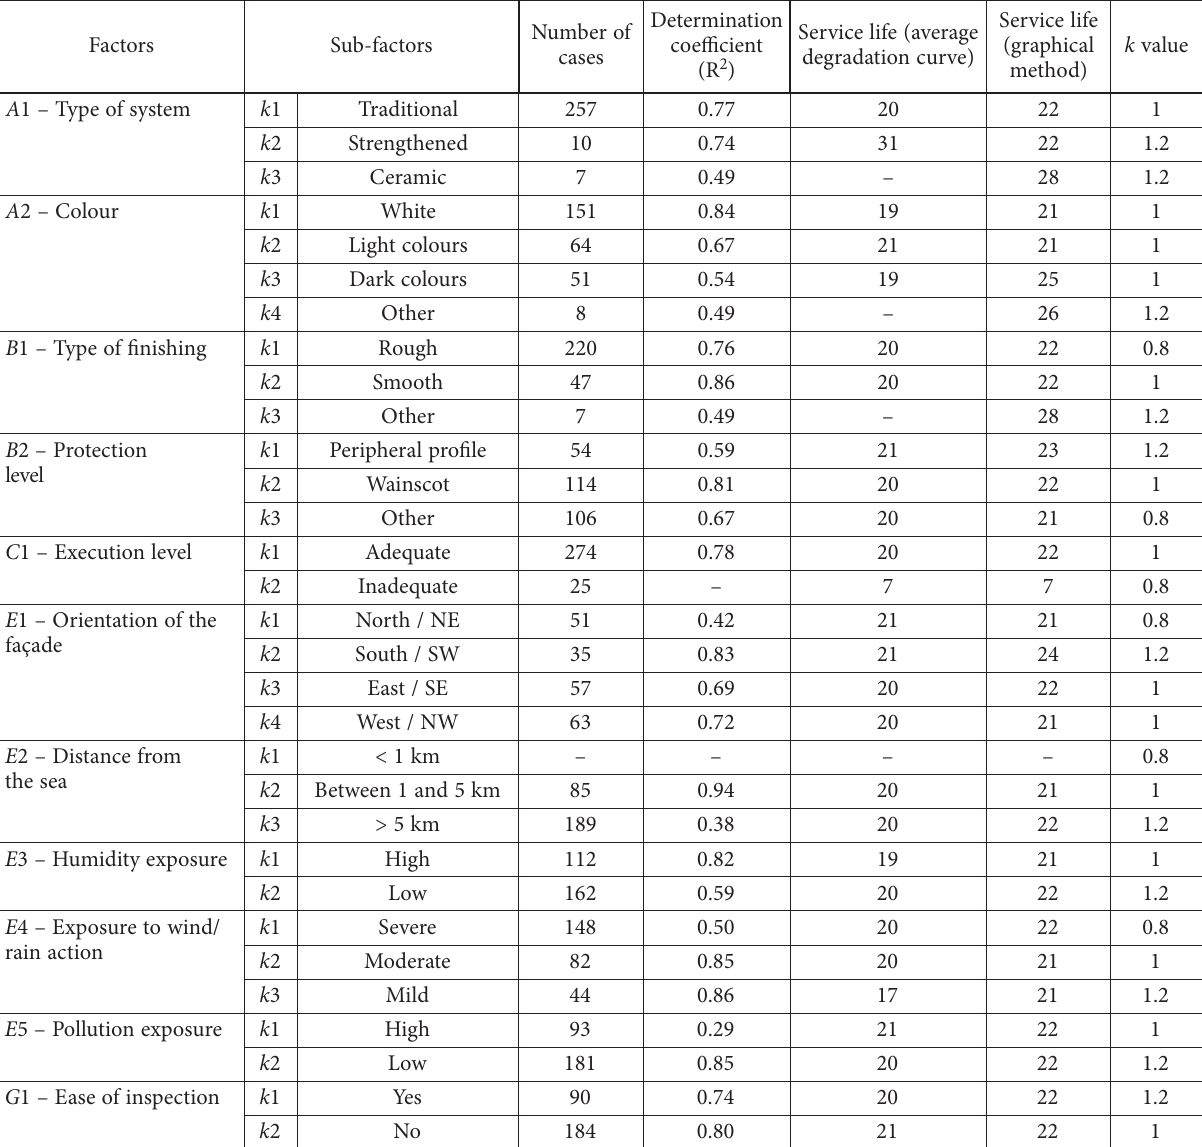
Table 1. Weighting values proposed by ISO 15 686-2